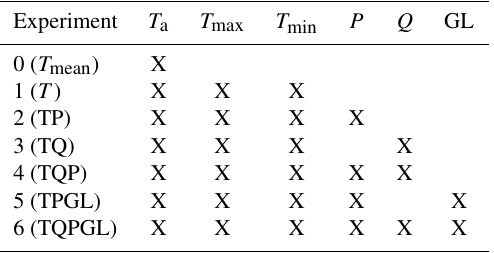
Table 2. Overview of available meteorological and hydrological variables and the composition of the different input data set exper- iments. If an input variable is used in a data set, the lags for the 4 previous days are included as well. Additionally to the shown vari- ables, all experiments use fuzzy months as